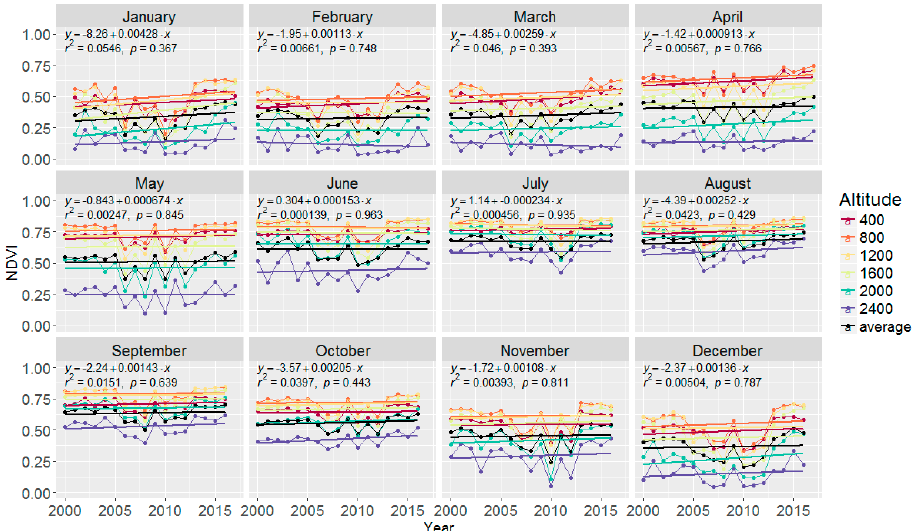
Figure 7. Monthly alpine-wide median NDVI of the years 2000–2017 in different altitude ranges. The formula, correlation coefficient and accuracy level are indicated for the median NDVI averaged over all altitudes.